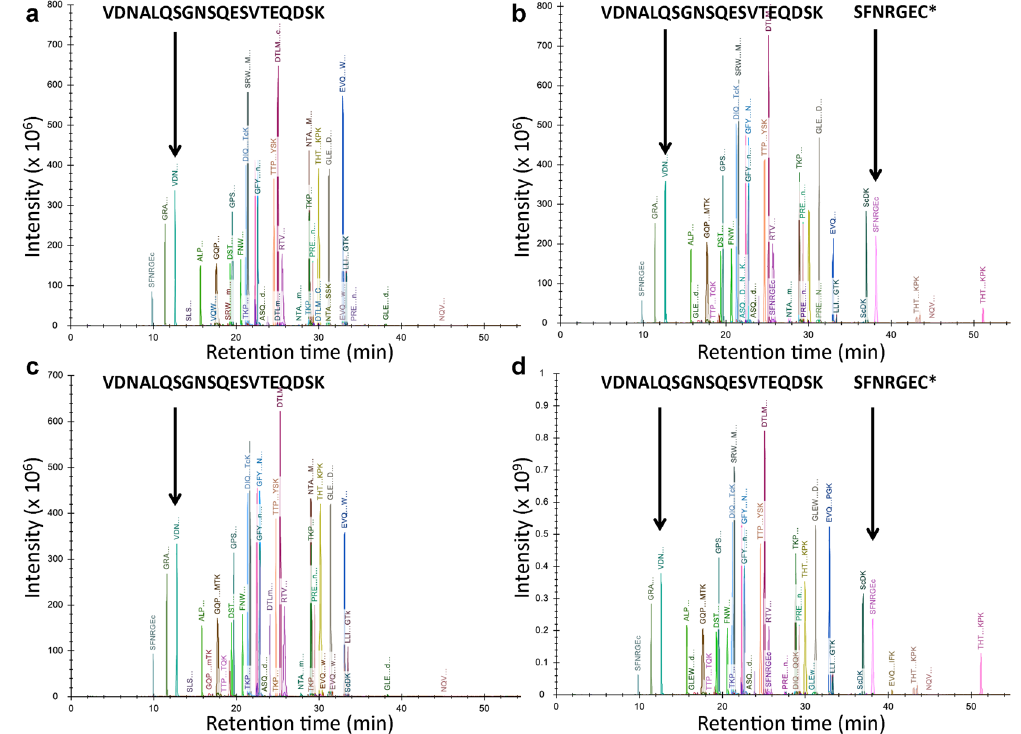
Figure 2. Representative extracted ion chromatograms for peptides from ( a ) AI and ( b ) ADC reference samples, and ( c ) AI and ( d ) ADC forced degradation (e.g., 3 mM AAPH) samples. Most peptides, including the unmodified peptide VDNALQSGNSQESVTEQDSK that can be used for normalization, were unaffected by the conjugation of linker drug. On the other hand, the linker-drug-modified peptides such as SFNRGEC were only observed in the ADC. In the ADC, the cysteine in this peptide was observed with carboxymethylation ( + 58 Da), vcMMAE- ( + 1315 Da), and vcMMAEhydro ( + 1333 Da) modifications. In the AI, the cysteine was fully carboxymethylated and no linker-drug modifications were observed. Comparisons of non-linker-drug modifications between reference samples provided negative control for differential site occupancy analysis while comparisons between reference samples versus their forced degradation samples provided positive